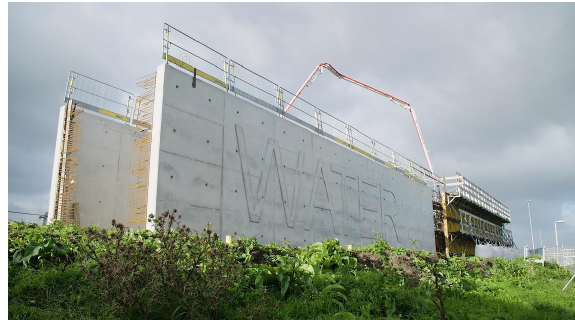
Figure 8. Full scale demonstrator In situ cast self ‐ healing concrete water reservoir, Hoogvliet, The